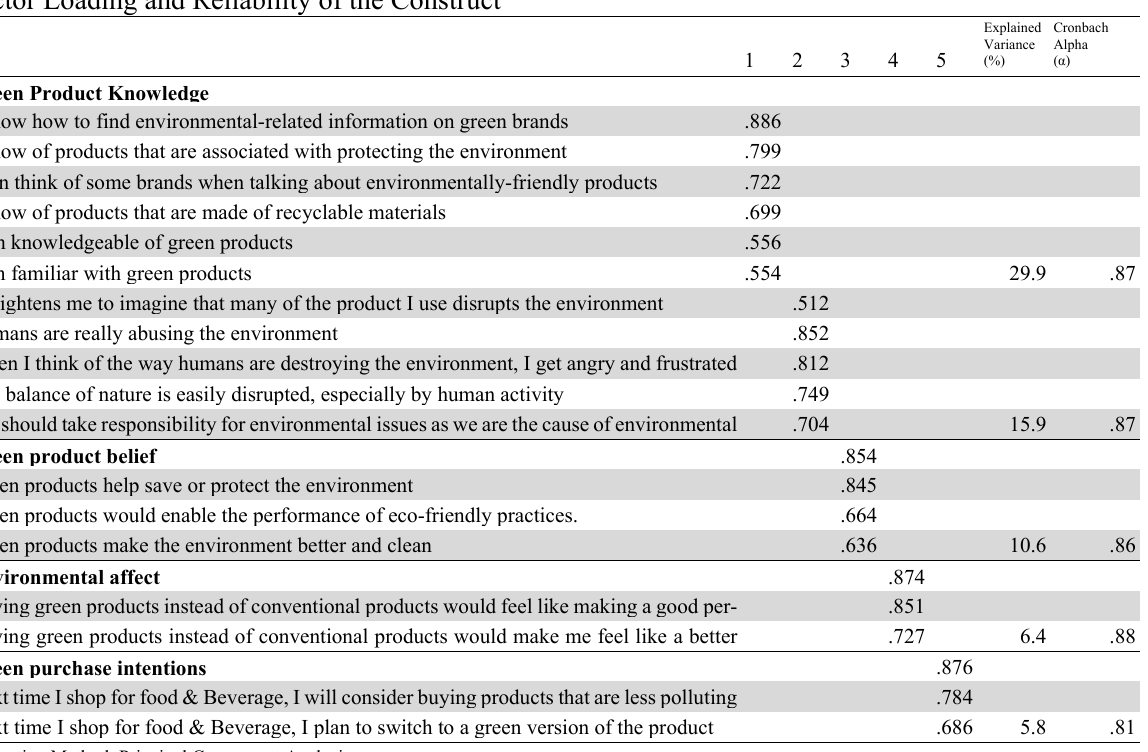
Factor Loading and Reliability of the